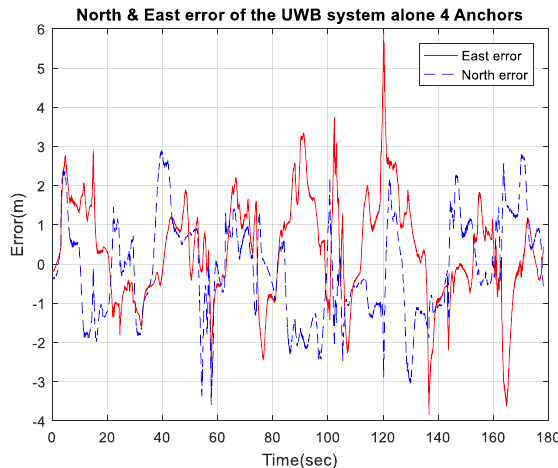
Figure 20. RMSE Errors trend in North and East directions for Figure 18. RMSE Errors trend in North and East directions for the proposed approach (camera and UWB) integrated with INS the UWB system with lower infrastructure utilized systems with lower infrastructure utilized for a complete 3- (configuration e) minute GNSS signal outage (configuration